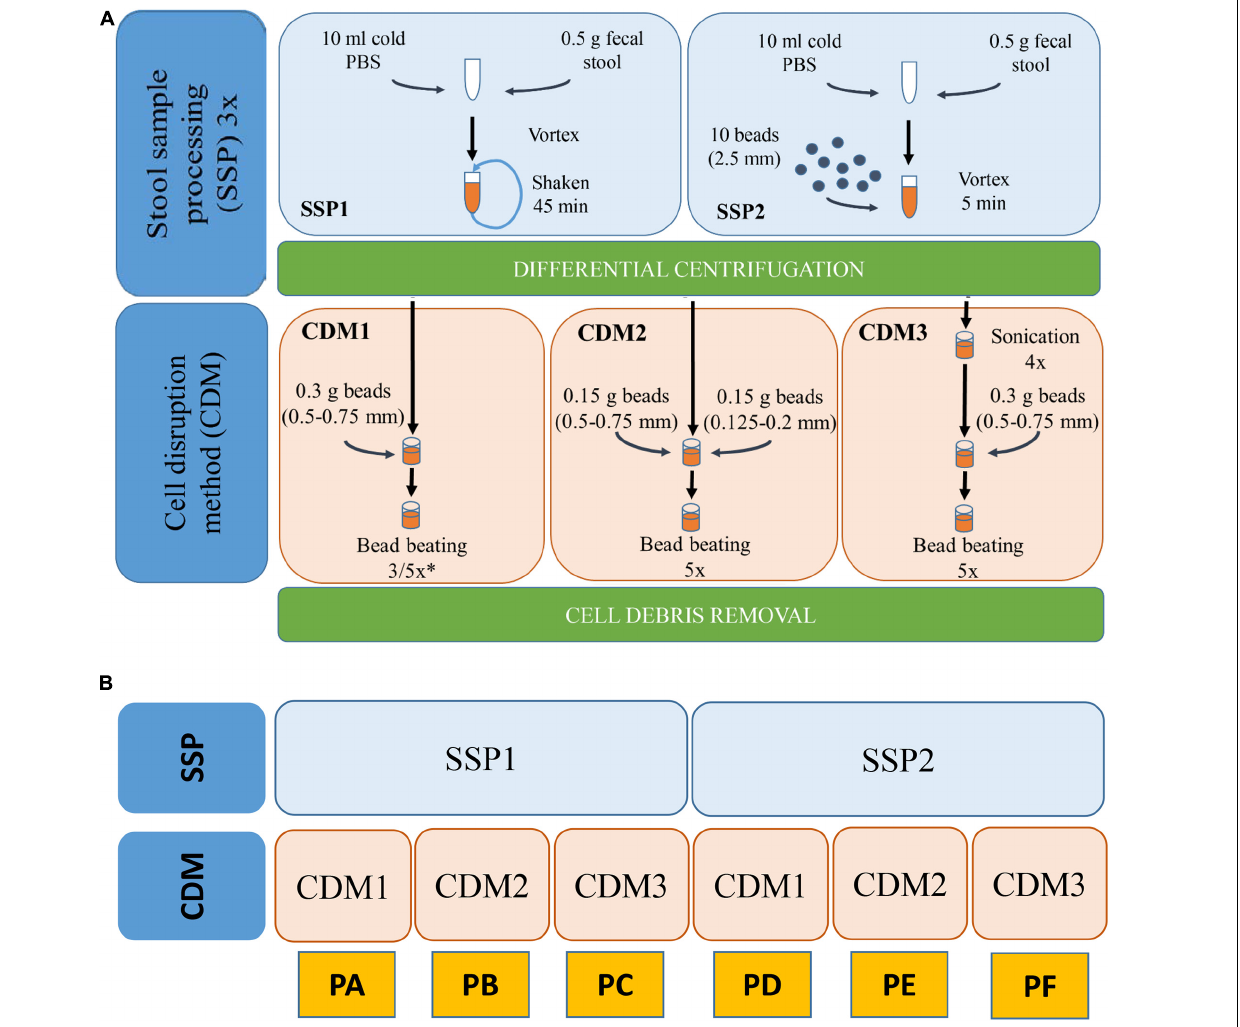
FIGURE 1 | (A) Workflow of the various SSP (stool sample processing) and CDM (cell disruption method) carried out with stool sample H1. (B) Schematic representation of the different combinations of SSP and CDM carried out in each protocol (PA–PF). ∗ In CDM1, 3 rounds were performed for PA and 5 rounds for